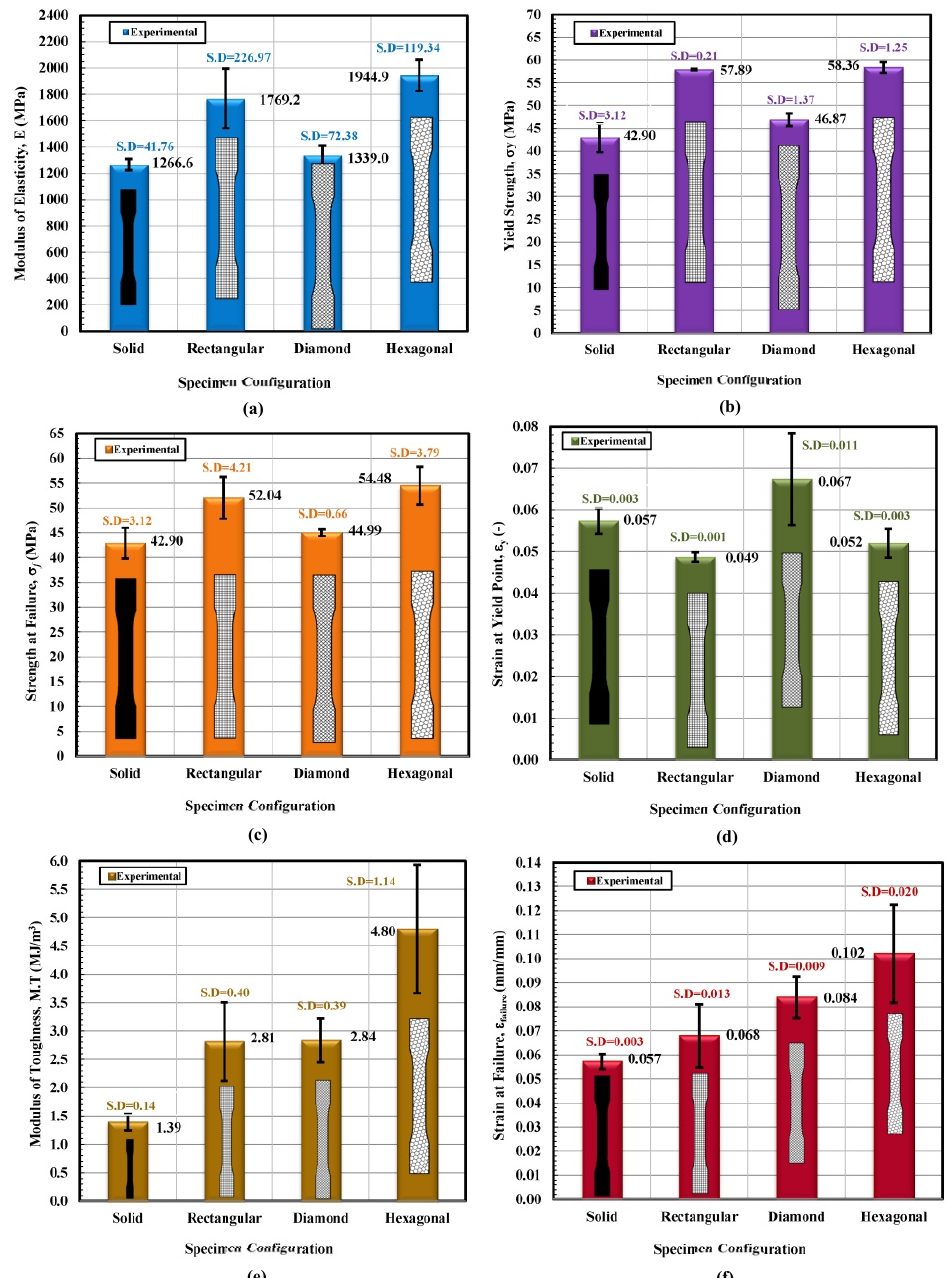
Figure 10. Stress vs. strain diagram showing an average trend line for each infill configuration as a function of ( a ) modulus, ( b ) yield strength, ( c ) strength at failure, ( d ) Strain at yield, ( e ) modulus of toughness, M.T, and ( f ) strain at failure.